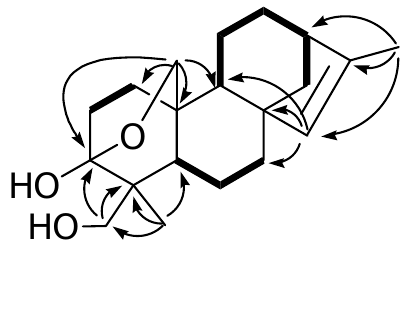
Figure 2. Key HMBC ( → ) and 1 H, 1 H COSY (  ) correlations of 1